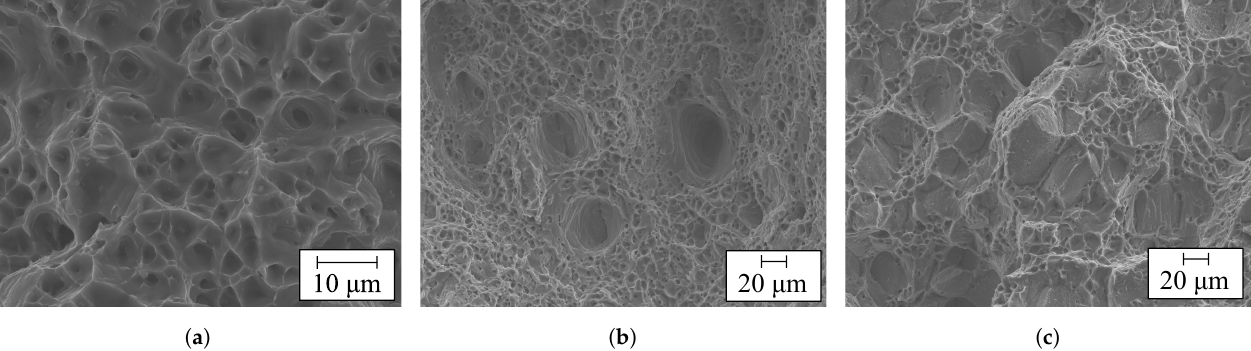
Figure 15. Fracture surfaces showing ( a ) a classic dimple structure (AA6061, smooth, 90 ◦ ), ( b ) large oversized dimples (AA6063, smooth, 22.5 ◦ ) and ( c ) facets due to intergranular fracture (AA6063, R2.0, 0 ◦